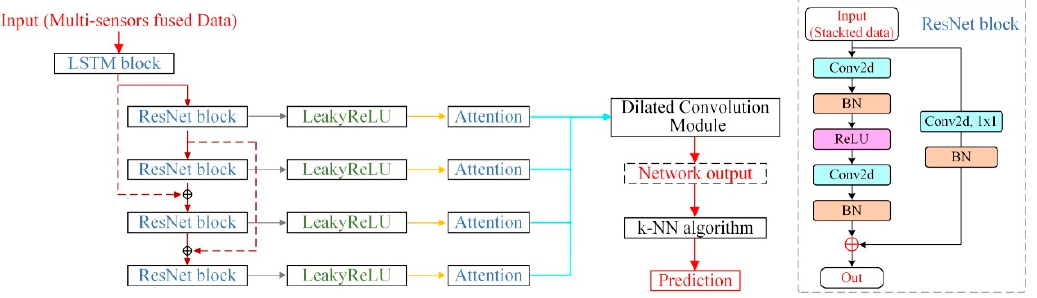
Figure 2. The network architecture of the proposed CNN-LSTM based on multi-sensor fusion.